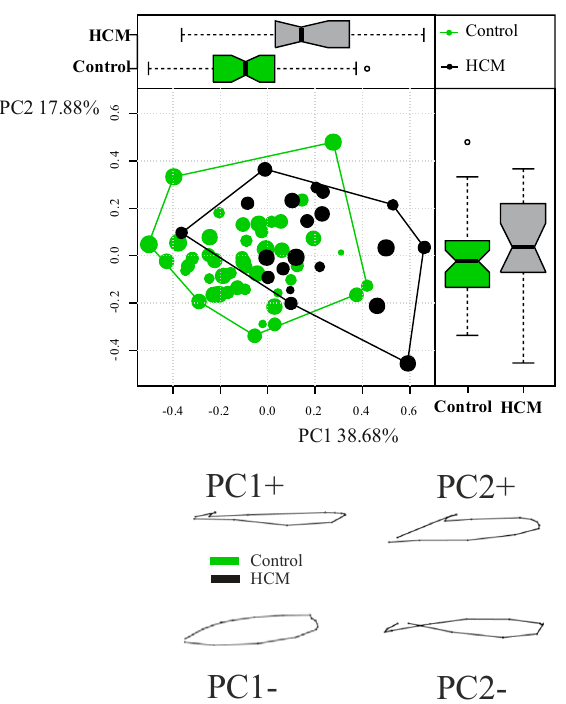
Figure 4. Shape analysis on trajectories shapes. Both PC1/PC2 scatterplot and boxplot distributions for each PC are shown. Trajectories shapes refer to PC extreme